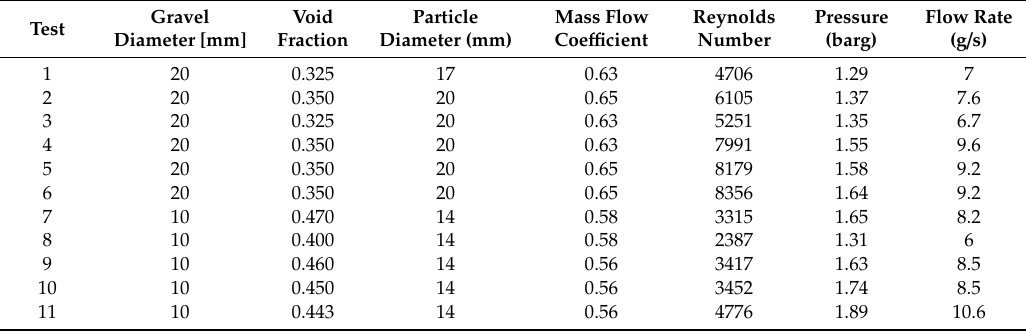
Figure 9. Effect of different void fraction and mass flow coefficients on the model results; 10 mm quartzite with constant particle diameter = 0.0014 mm. Table 3. Summary of predicted void fraction, particle diameter and mass flow coefficients for all cases.